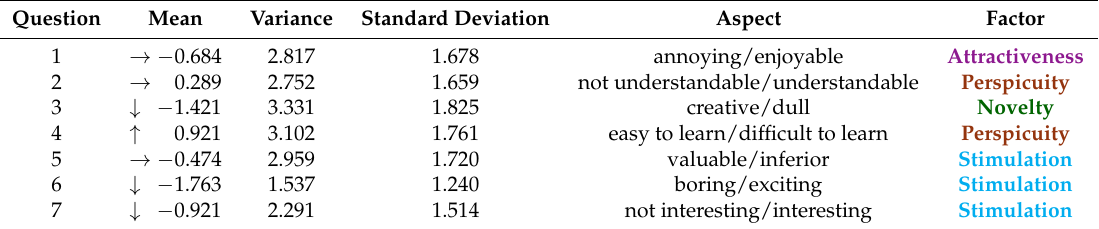
Table A2. Post-task questionnaire results for the Baseline information presentation model. The first column shows the order of the questions posed to participants; the second one shows the mean rating they gave: → denotes a neutral value, ↓ a negative one and ↑ a positive one. The third and fourth colums report variance and standard deviation of ratings. The Aspect column shows the UX aspect associated to the question and the last column recaps the Factor to which the aspect